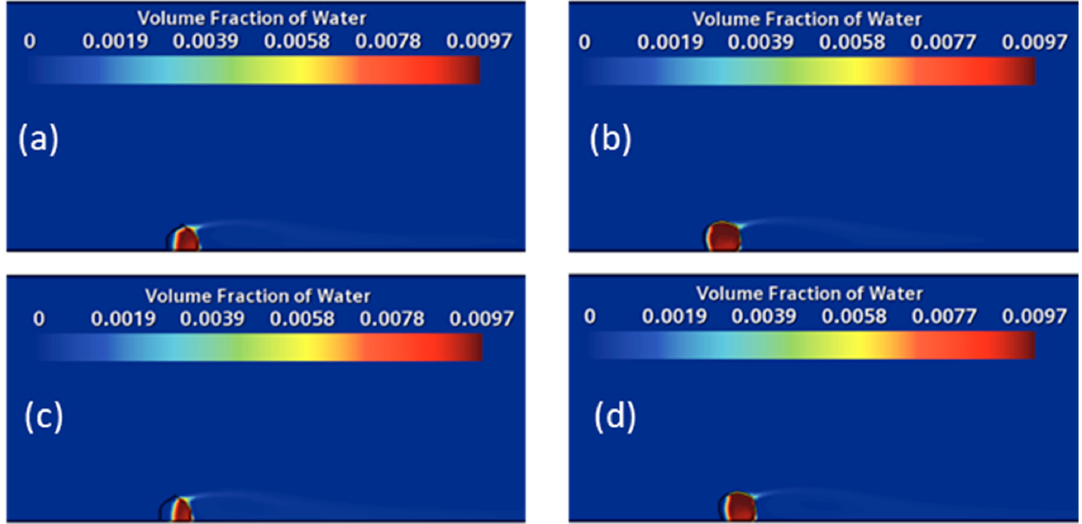
Figure 8. Volume Fraction of Water extrapolated from the CFD simulation. ( a ) Nero Spinoso at 0.5 s; ( b ) control (B73/Mo17 hybrid) at 0.5 s; ( c ) Nero Spinoso at 1 s; ( d ) control at 1 s.